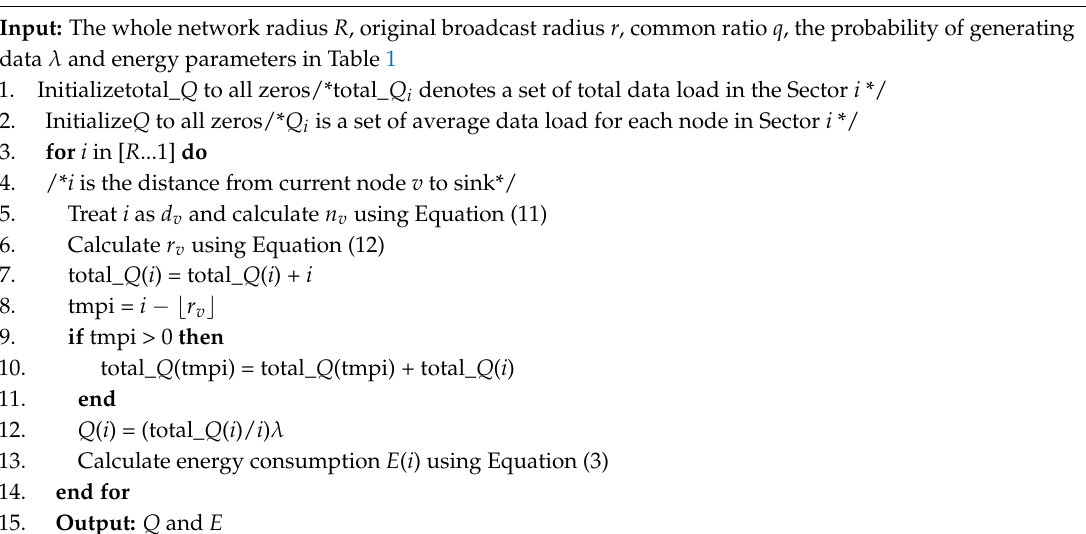
Algorithm 2: Discrete method to calculate data load and energy consumption